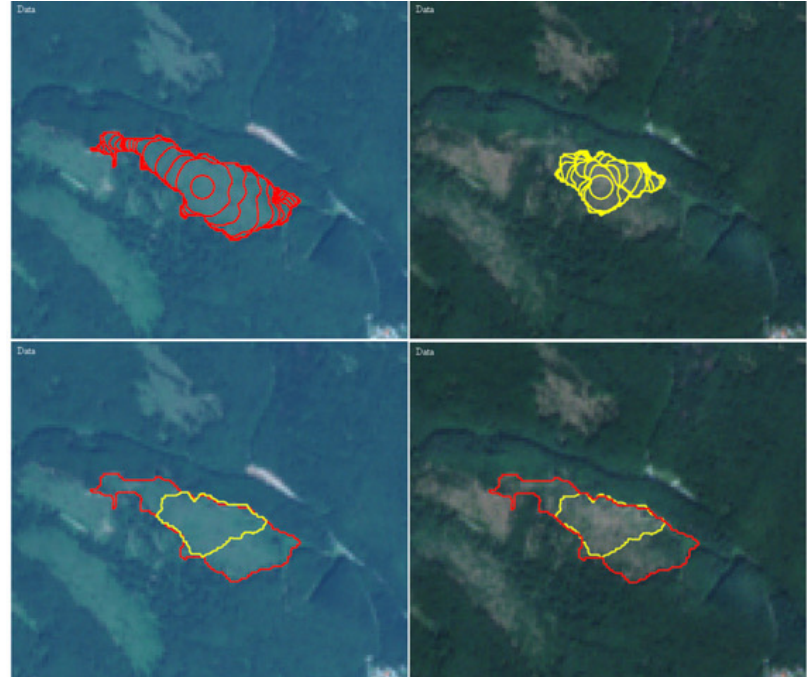
Figure 12. The grassland habitat segmentation. The top left image shows segmentation (red) in the Figure 12. The second example of the grassland habitat segmentation. The top left image shows original data from 2015. The top right image shows segmentation (yellow) in the updated data from segmentation (red) in the original data from 2015. The top right image shows segmentation (yellow) 2019. The bottom row compares visually the final segmented areas illustrated on both original and in the updated data from 2019. The bottom row compares the final segmented areas before and after updated data. successional Table 5. Characteristics of the final segmentation curves from Figure 12 final segmented areas show- ing their difference in area, perimeter, isoperimetric ratio and classical (HD) and mean (MHD) Hausdorff distances of two segmentation curves.